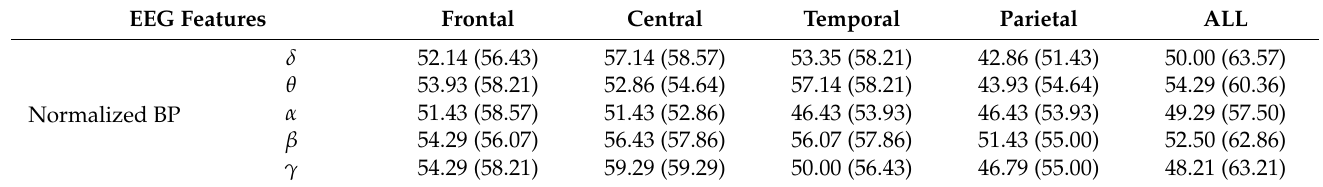
Table 7. Five-fold cross validation accuracies among different frequency bands and scalp regions using a normalized BP and a LDA classifier (in %). The numbers inside and outside the brackets denote the accuracies obtained from the features with and without the SBS-based feature